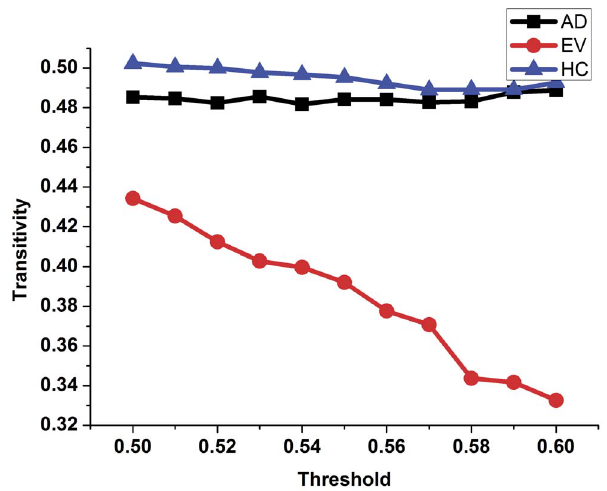
Figure 6. The transitivity of the functional brain network of the healthy controls, AD patients and evolution under different thresholds. Blue triangles represent the healthy control group, black rectangles represent the group of patients with AD, red dots represent the evolution network group.